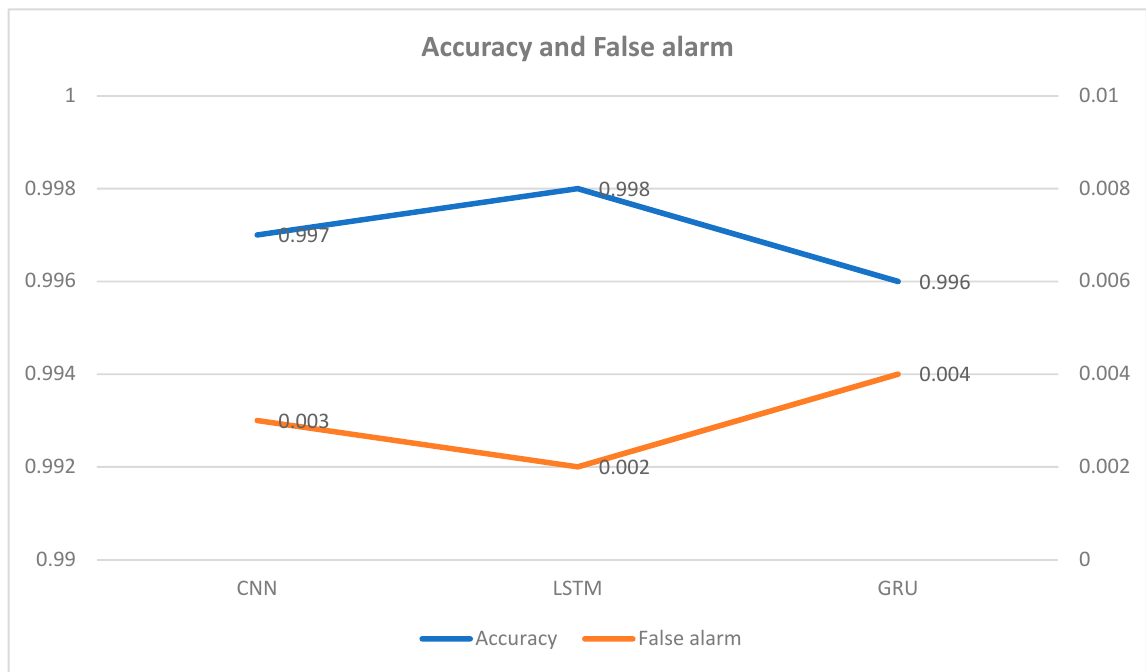
Table 6. Model comparison with other state-of-the-art